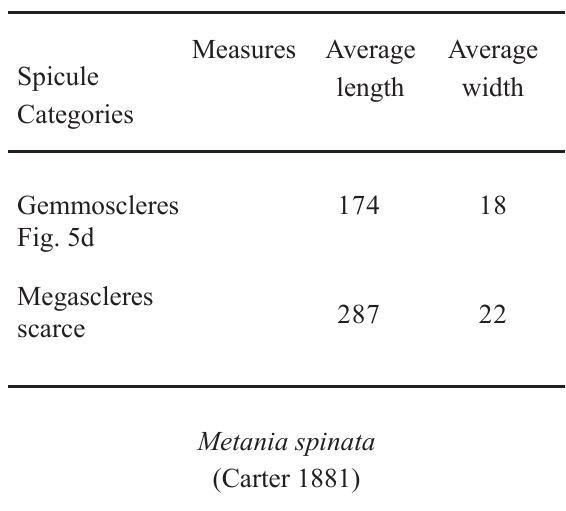
Category and measures (µm) of spicules of O. navicella detected in the studied sections. Spicules are scarce; however, the gemmoscleres are more robust than reported in the original description.